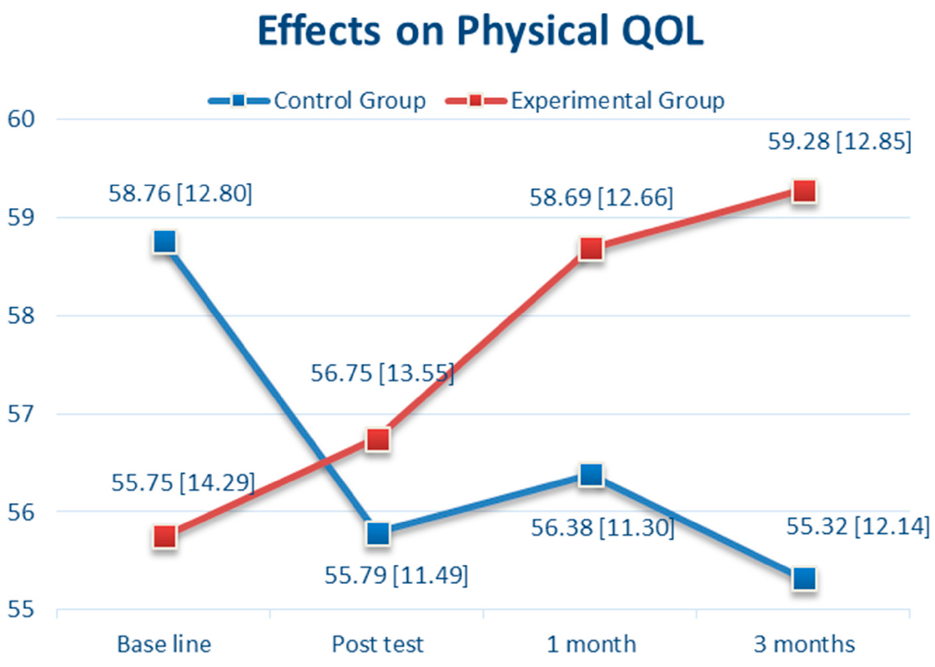
Figure 6. The Effects over Time of Cognitive Behavioral Therapy (CBT) on Physical Quality of Life